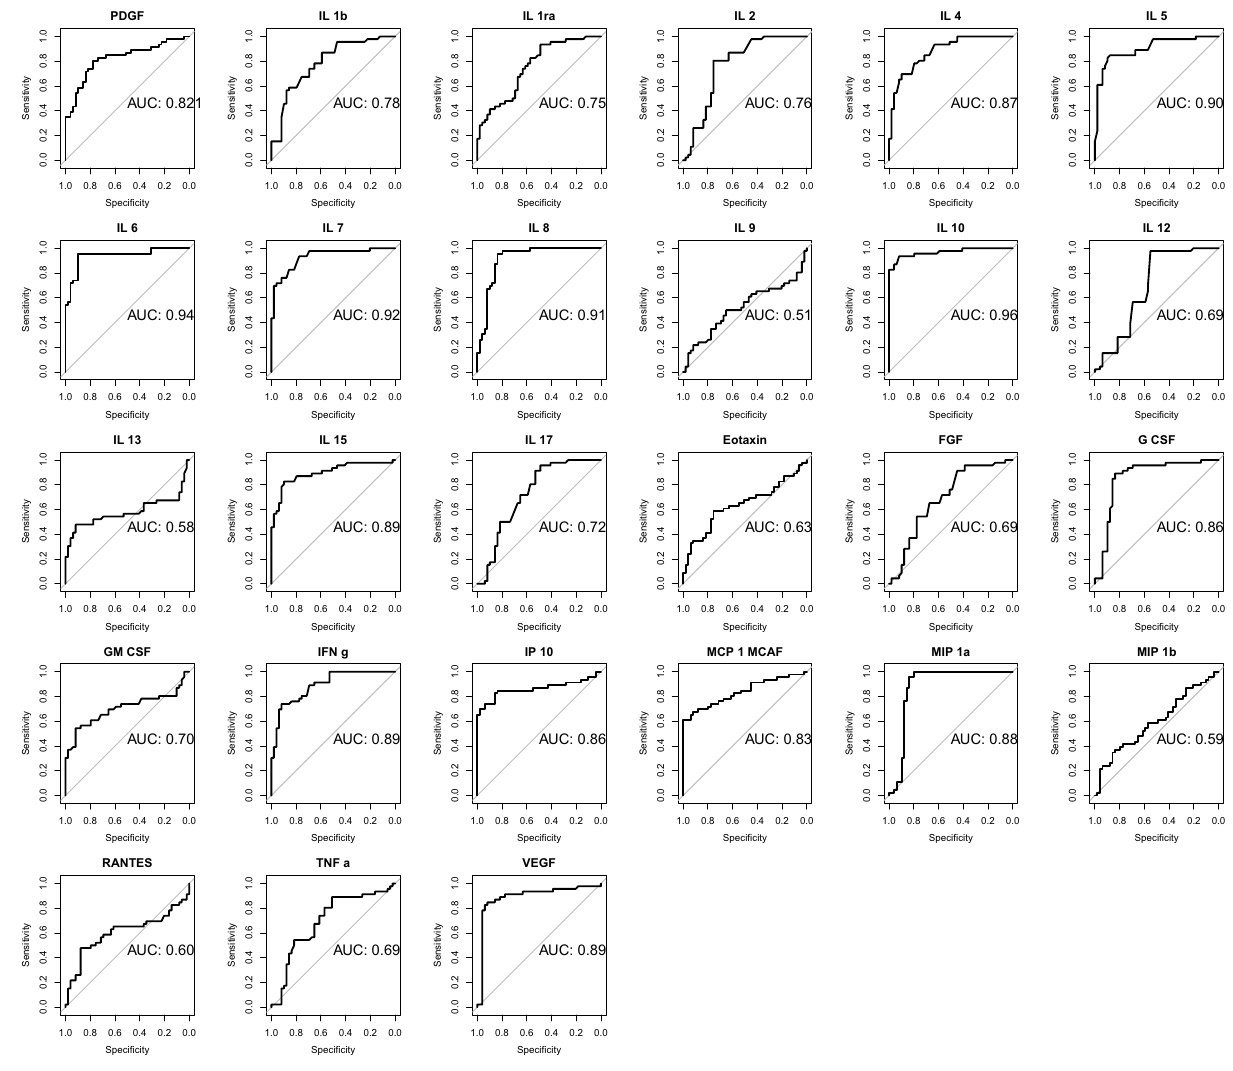
Figure 4. Diagnostic relevance of COVID-19 related cytokines. The diagnostic performance of cytokines, chemokines and growth factors was estimated using ROC curve analysis and compared with the AUC in Controls versus Mild + Severe COVID-19